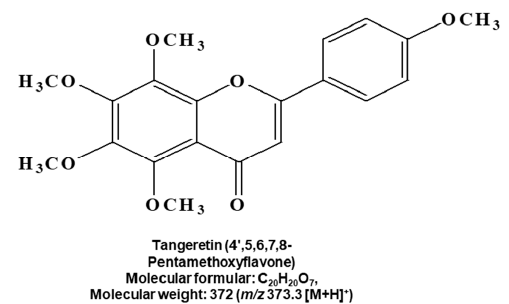
Figure 2. Chemical structure of the compound purified from citrus. Chemical structure of tangeretin.